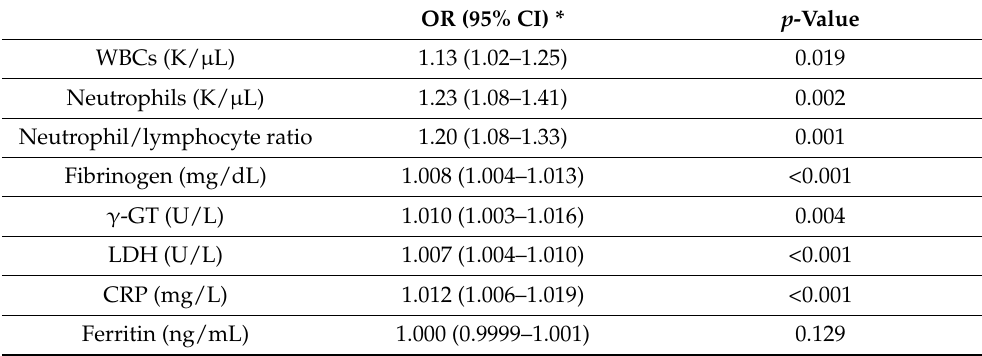
Table 3. Association of laboratory parameters at hospital admission with critical COVID-19 after ad- justment for age, sex and time from symptom onset in the absence of comorbidities (derivation cohort). OR (95% CI) * p -Value WBCs (K/ µ